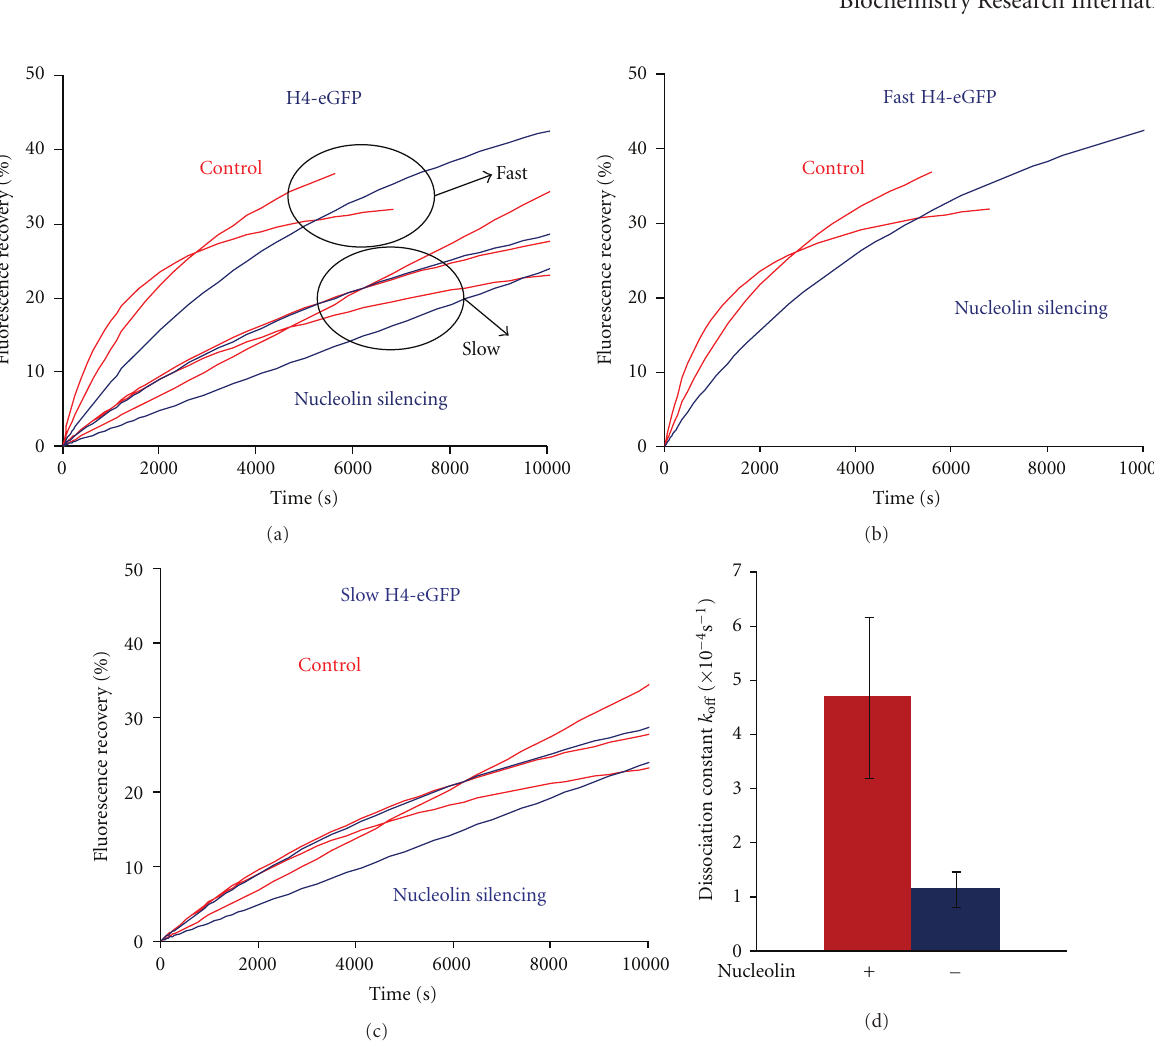
(Figure 5). The fluorescence recovery of macroH2A-eGFP in control and nucleolin depleted cells was plotted against time (Figure 5(a)) and the average normalized fluorescence recovery for each condition was calculated (Figure